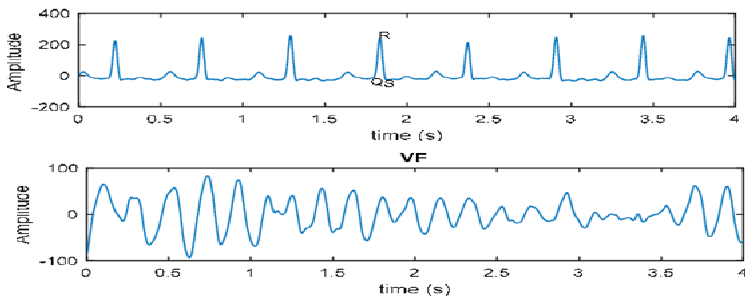
Figure 18. Comparison of Ventricular and Normal sinus rhythm signals.